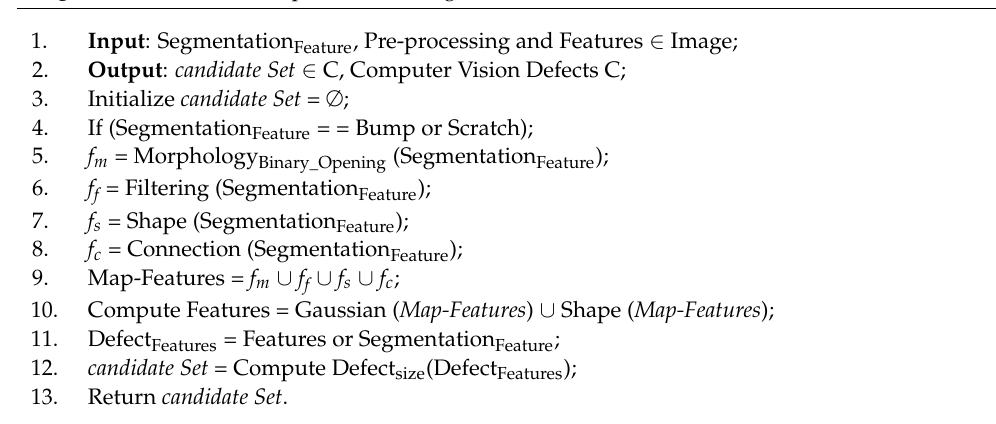
Algorithm 2 AOI for Computer Vision